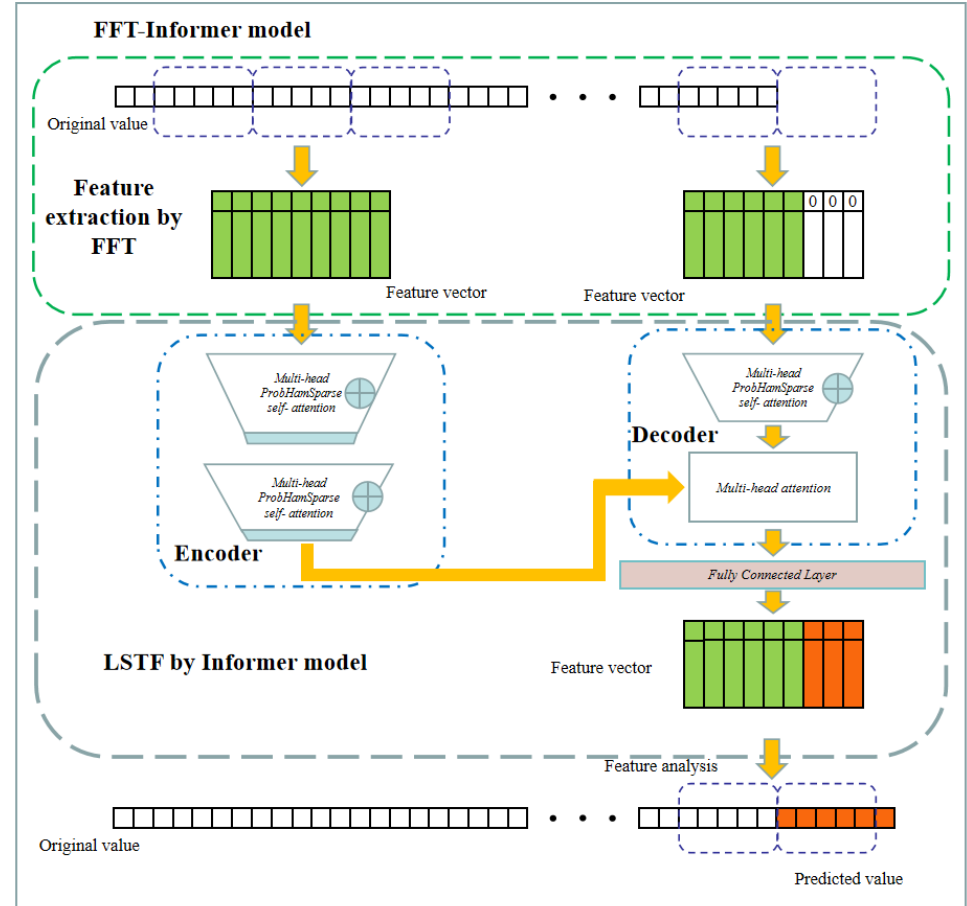
Figure 1. Framework of the FFT–Informer